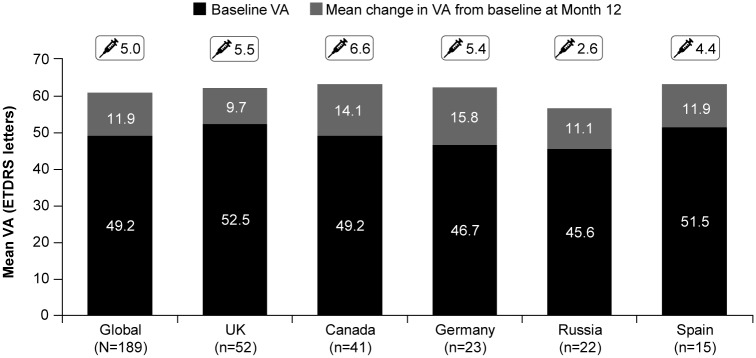
Mean change in VA from baseline at Month 12.Primary treated eye set, defined as the number of evaluable patients with baseline and Month 12 data who have been in the study for at least 365 days. Syringe symbol denotes mean number of injections from baseline to Month 12. There were only 2 patients from India with baseline and Month 12 VA data who have been in the study for at least 365 days. Therefore the mean VA has not been shown for the patients from India. ETDRS, Early treatment diabetic retinopathy study; VA, visual acuity.